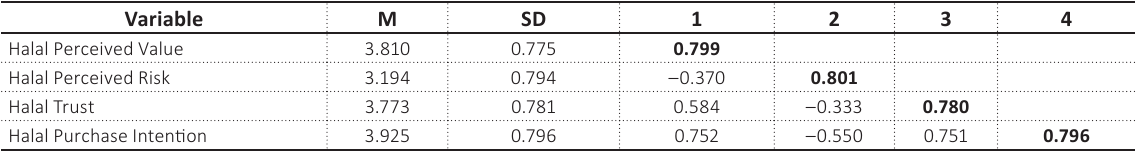
Note : Values on the diagonal (bold) are the square root of the AVEs of respective